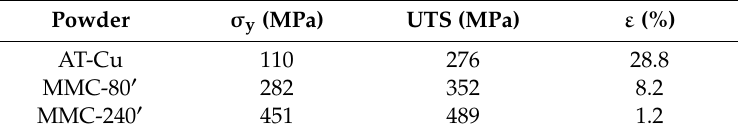
Table 2. Mechanical properties of AT ‐ Cu, MMC ‐ 80 ′ and MMC ‐ 240 ′ .